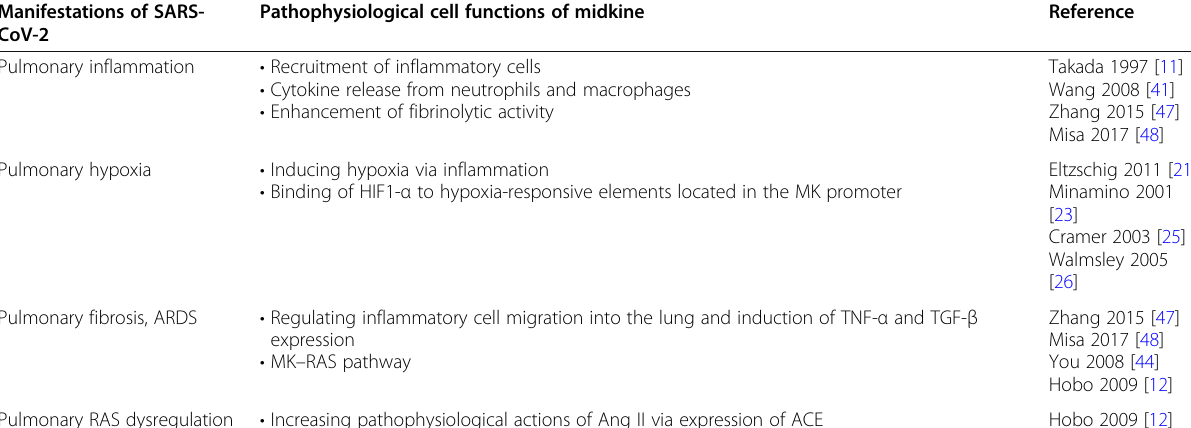
Table 1 The possible involvement of MK overexpression to SARS-CoV-2 manifestations Manifestations of SARS- Pathophysiological cell functions of midkine CoV-2